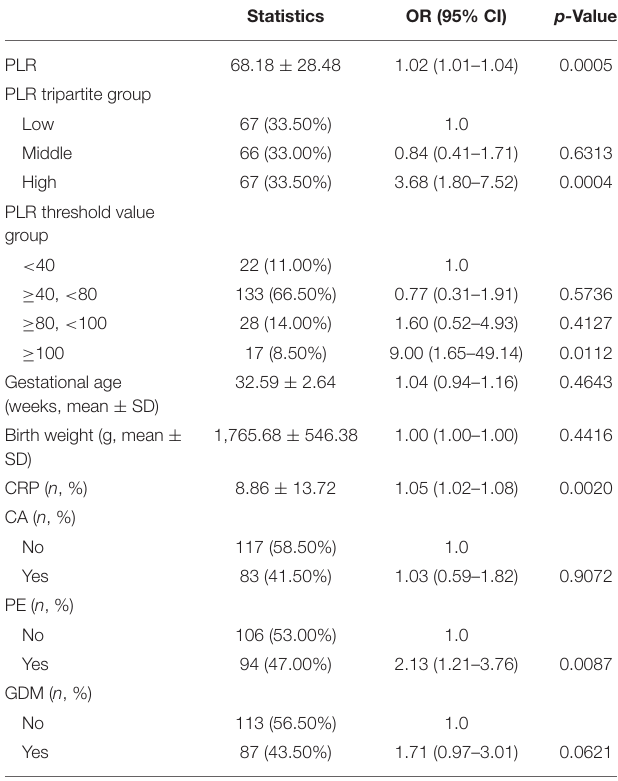
TABLE 2 | Univariate analysis for NEC.